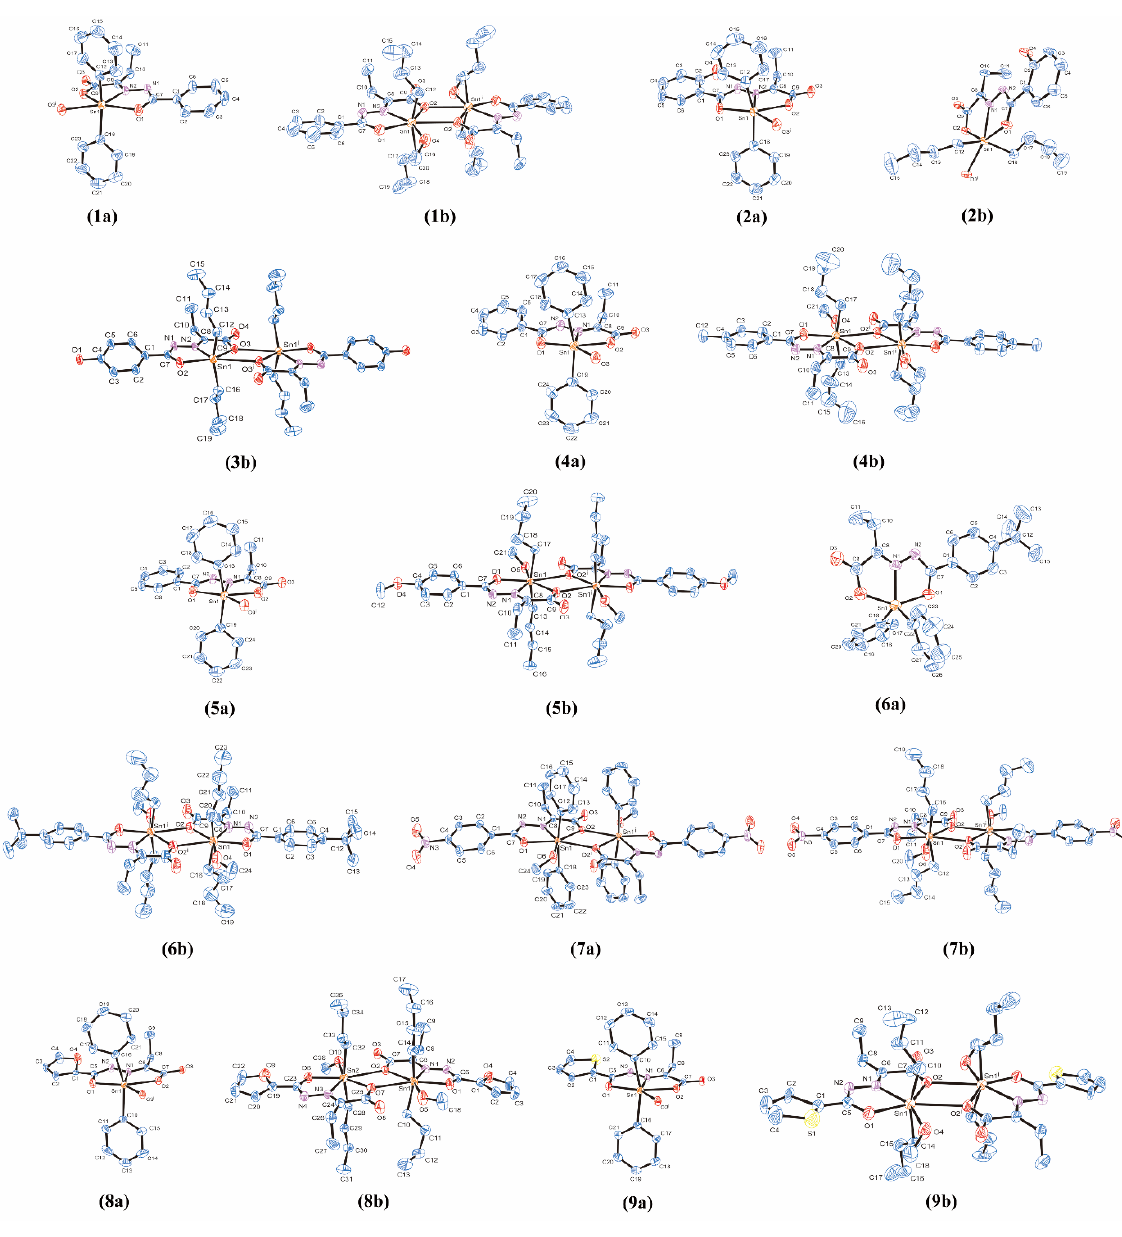
Figure 1. Molecular structure of 1a – 9b.